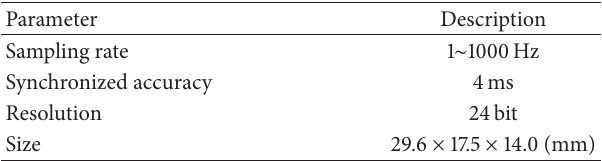
Table 2: Data-logger